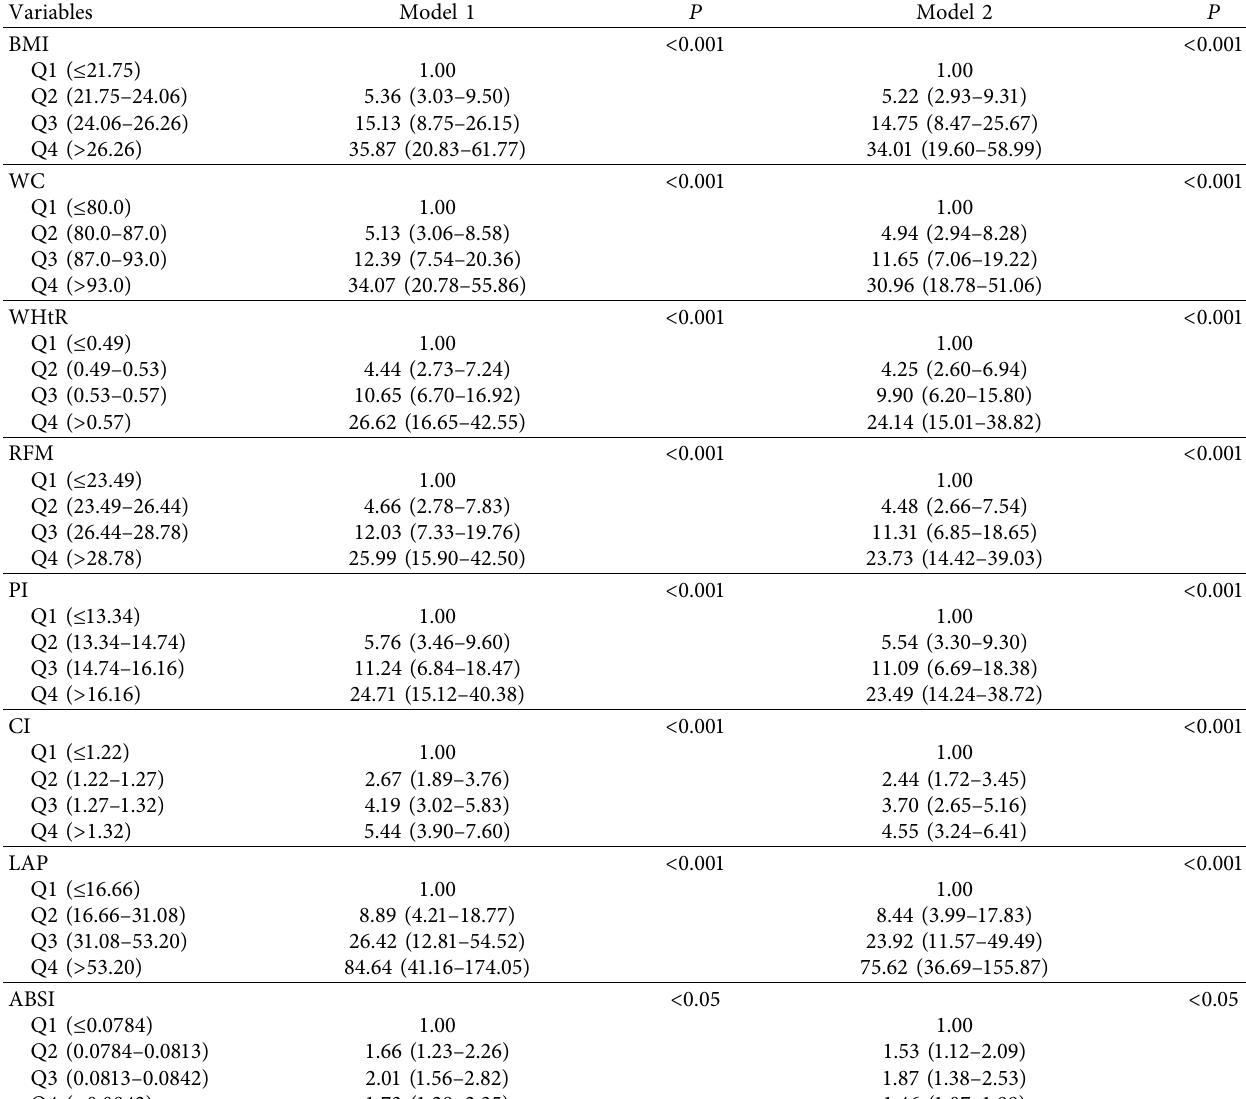
Table 3: Multivariate logistic of anthropology indexes for NAFLD in